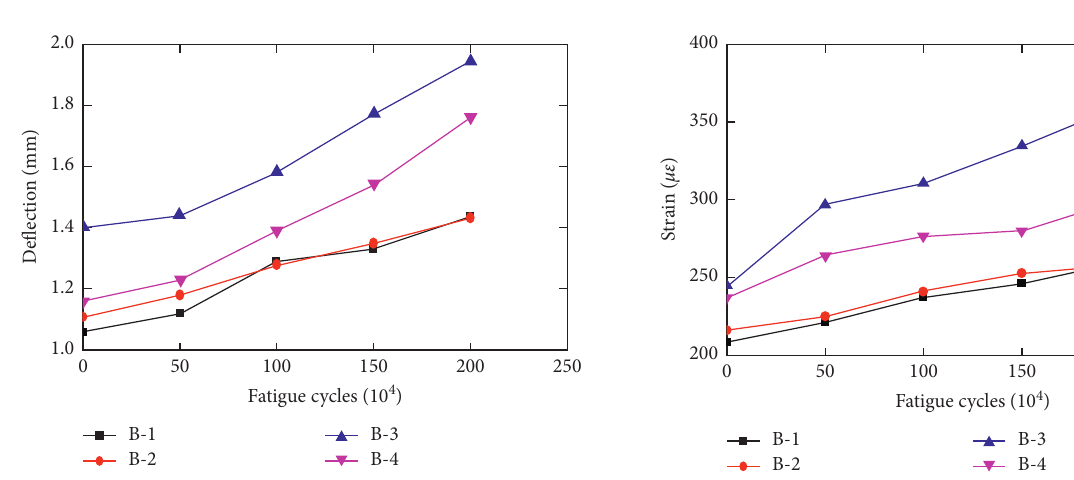
Figure 23: The relation between midspan tensile strain and fatigue cycle times for different test beams. B-1: uneroded carbon-fiber- reinforced test plate, B-2: uneroded bonded steel-plate-reinforced test plate, B-3: carbonized eroded carbon-fiber-reinforced test plate, and B-4: carbonized eroded bonded steel-plate-reinforced test